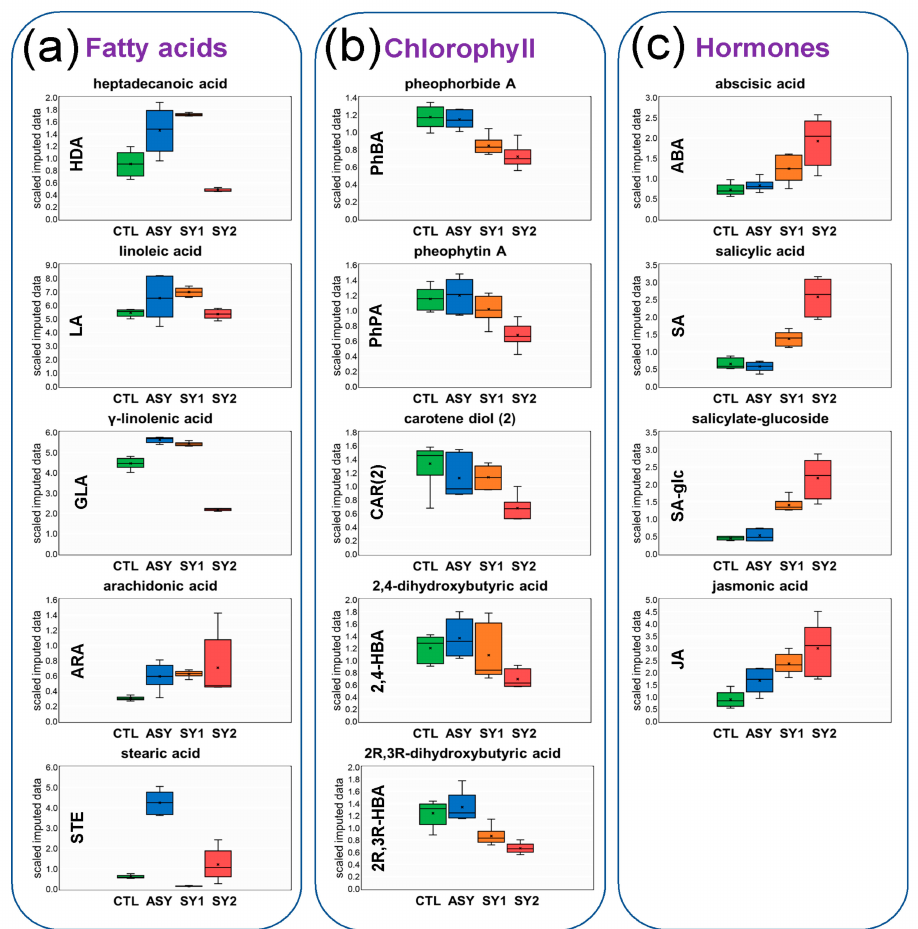
Figure 6. Box-And-Whisker plots corresponding to hormones, lipid species, and other compounds of the metabolism of lipids with specific and consistent changes in response to Esca complex disease (ESCA) in Vitis vinifera L. ‘Malvasia Fina’ leaves. Scaled imputed data were calculated by median value normalization of area-under-the-curve detector ion counts for each compound (names on the top and abbreviations on the Y -axis). The rounder corner shapes delimit a cluster of individuals of similar sub-pathways: ( a ) Free FAs, ( b ) hydroxy FAs and metabolites of chlorophyll / carotenoid metabolism, and ( c ) hormones. CTL = healthy leaves from healthy una ff ected control vines, ASY = healthy leaves from foliar-asymptomatic and wood-symptomatic vines, SY1 = chlorotic leaves from foliar-symptomatic and wood-symptomatic vines, SY2 = spotted / scorched leaves from foliar-symptomatic and wood-symptomatic vines. High levels of ARA probably produced by grapevine pathogens were found and the compound included in the